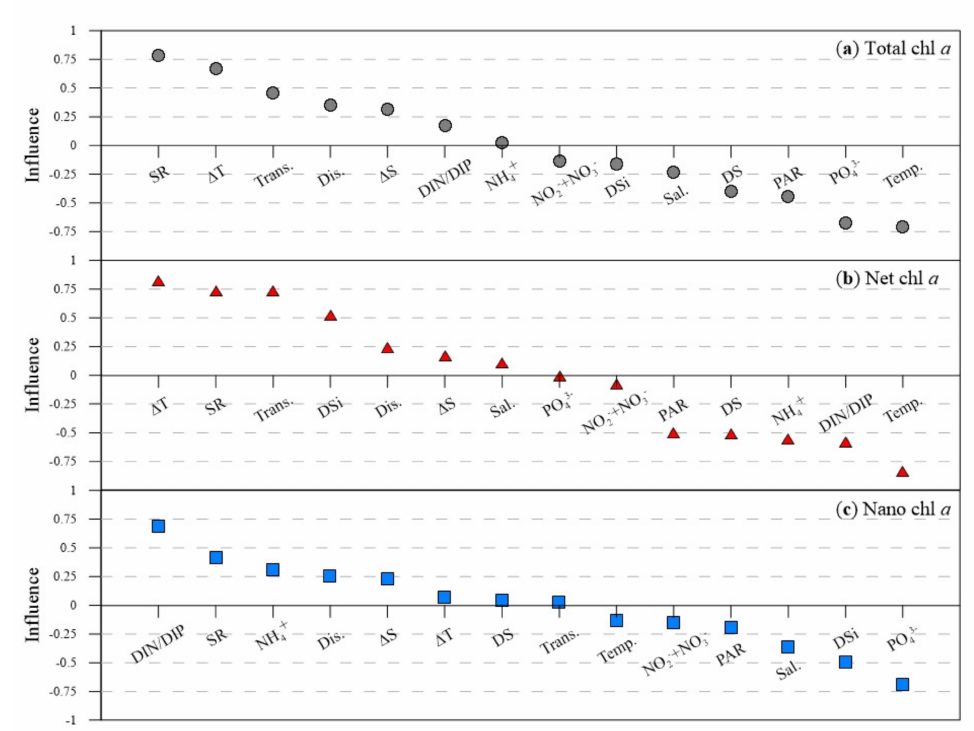
Figure 6. Influence of input parameters (environmental factors) on the predicted chlorophyll a values in the ANN model. ( a ) chlorophyll a of total phytoplankton, ( b ) chlorophyll a of net-sized phytoplank- ton, and ( c ) chlorophyll a of nano-sized phytoplankton (Dis.: discharge; Temp: water temperature; Sal.: salinity; ∆ T: surface and bottom temperature difference; ∆ S: surface and bottom salinity differ- ence; Trans.: transparency; PAR: photosynthetically active radiation; DS: duration of sunshine; SR: solar radiation; NO 2 − + NO 3 − : nitrite + nitrate; NH 4+ : ammonium; DSi: dissolved silicate; PO 43 − : phosphate; and DIN/DIP: dissolved inorganic nitrogen to dissolved inorganic phosphorus